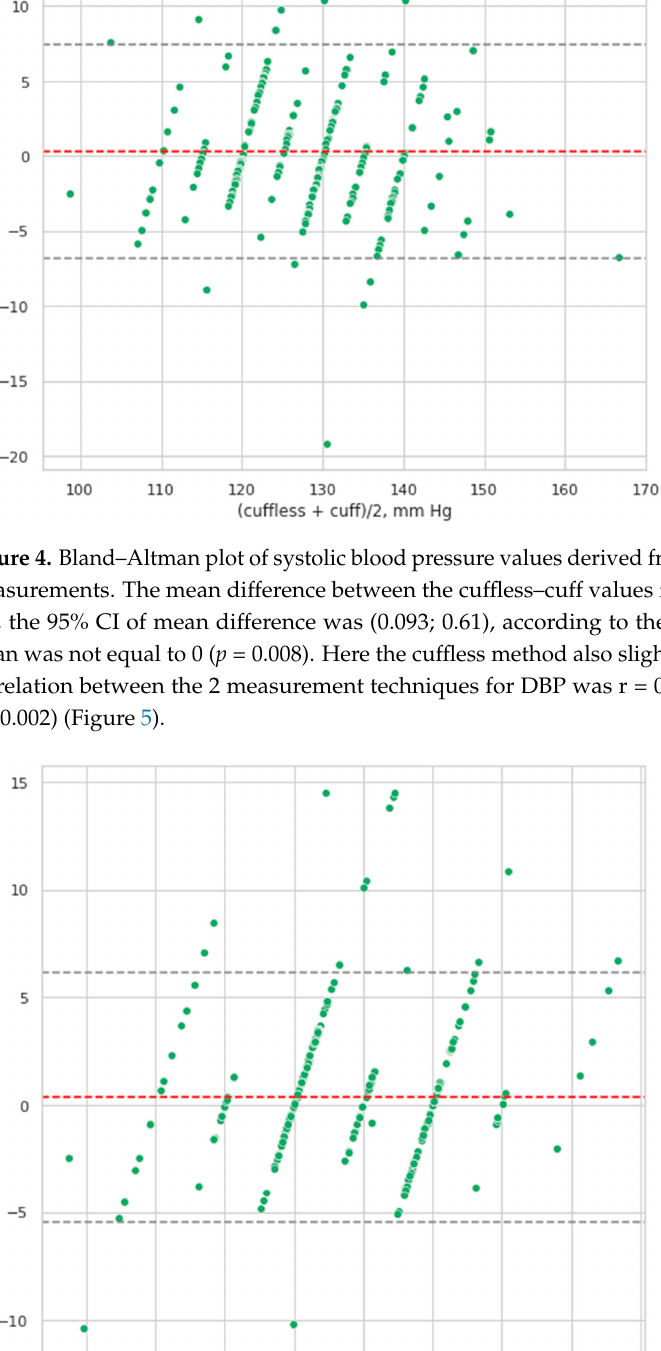
Figure 6. Boxplots of deviations between the two methods in the whole group ( n = 500) and in three subgroups (BP < 110/70, n = 14; 110/70–140/90, n = 420; >140/90, n = 66) according to the cuff- based results. Mean and median error differed in different subgroups. Wilcoxon rank test was